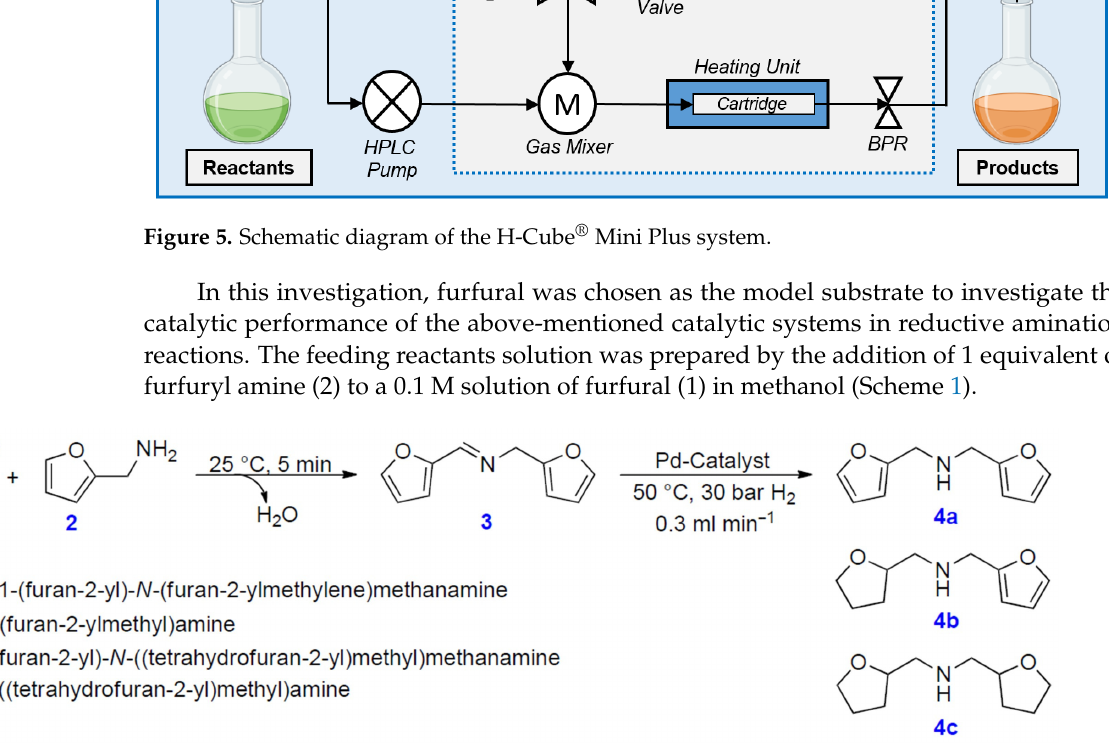
Scheme 1. Reaction pathway in the reductive amination of furfural and furfuryl amine.